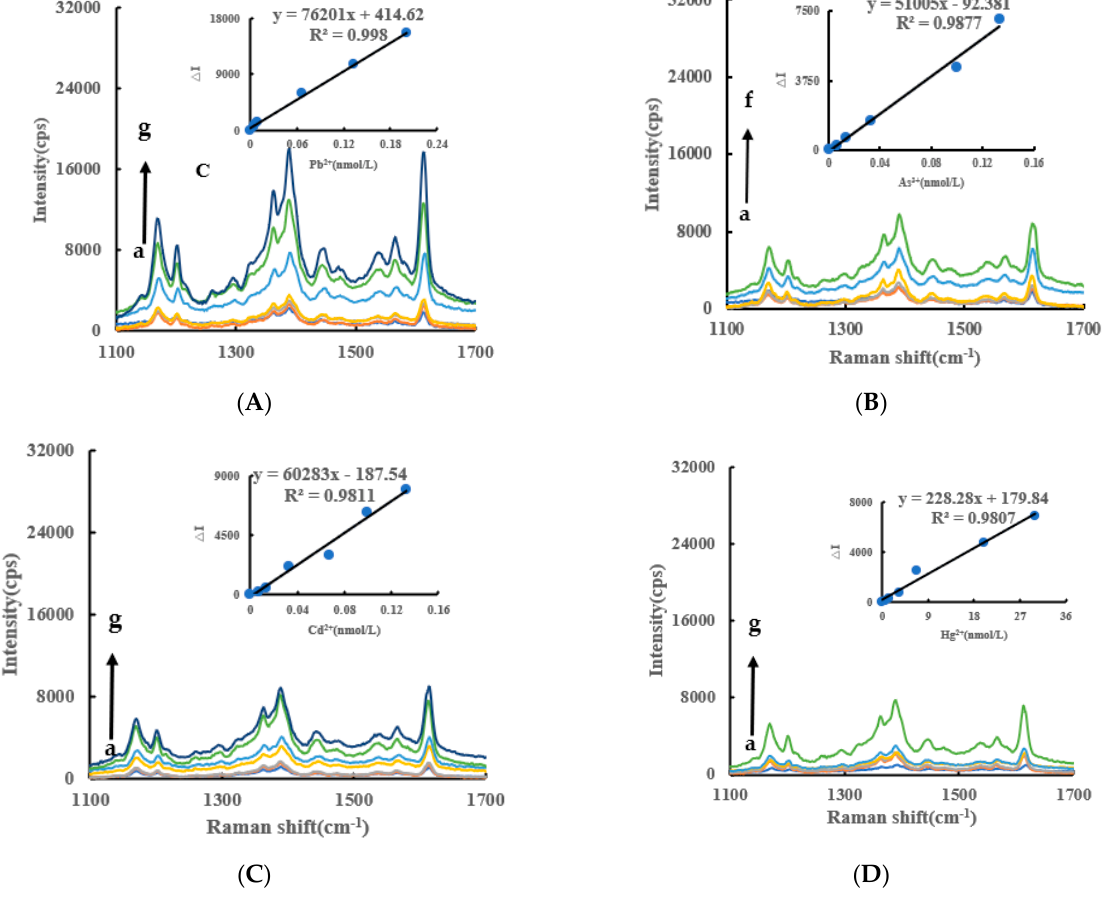
Figure 4. SERS spectra of the CB@AgNPs -Fo-AgNO 3 -Apt-inorganic pollutants system. ( A ): a–g: (0, 4.47 × 10 − 3 , 6.7 × 10 − 3 , 8.94 × 10 − 3 , 6.7 × 10 − 2 , 0.133, 0.201) nmol/L Pb 2+ + 0.667 nmol/L Apt Pb + 73.98